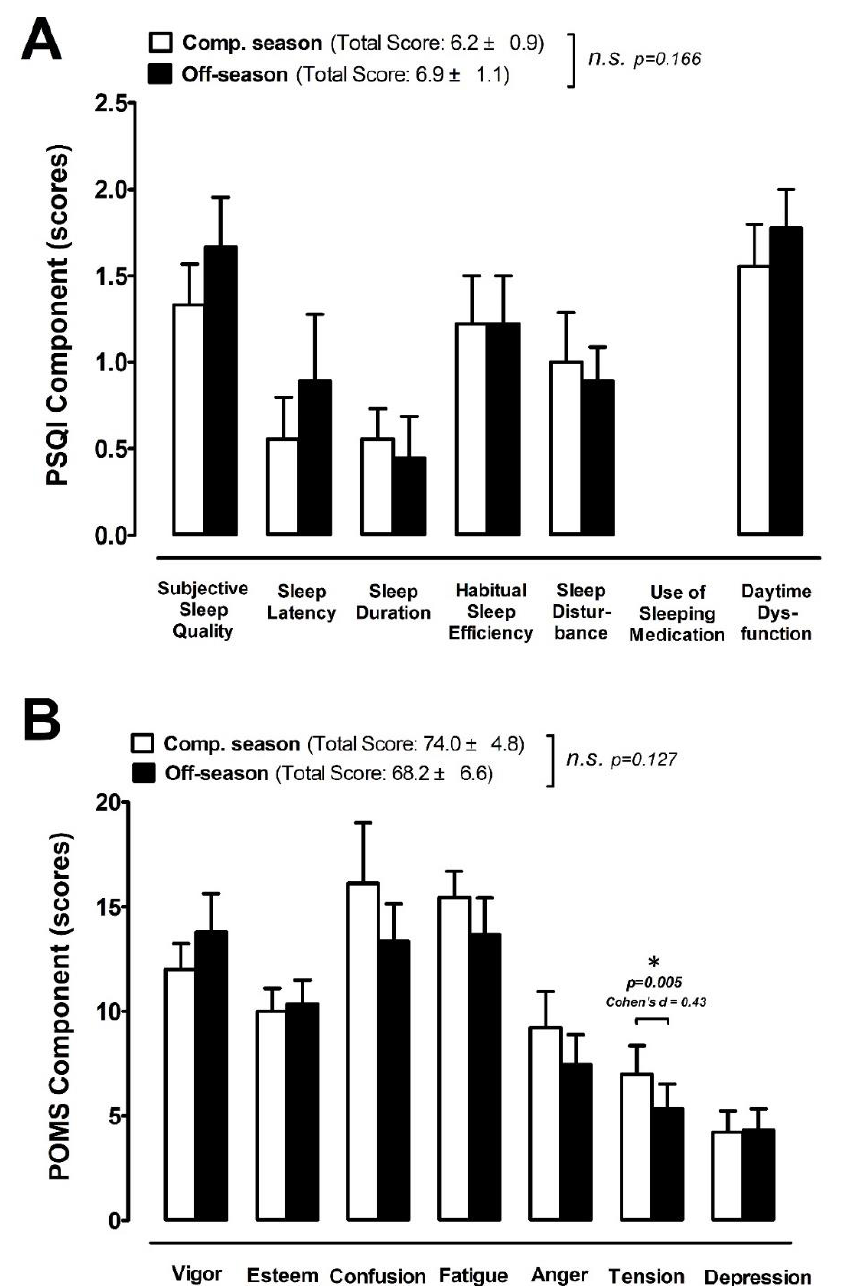
Figure 6. Sleep quality and mood state. ( A ) Pittsburgh Sleep Quality Index (PSQI) and ( B ) Profile of Mood State (POMS) were measured at the competitive season and off-season (competitive season, open bar; off-season, black bar). Data are expressed as Mean ± S.E.M. * denotes significant difference between two phases ( p < 0.05). Comp. season: competitive season (CS), off-season (OS).